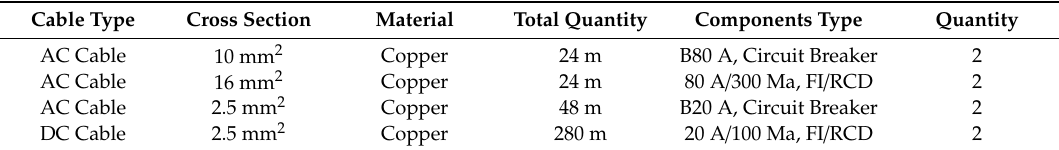
Table 6. Cable Overview.